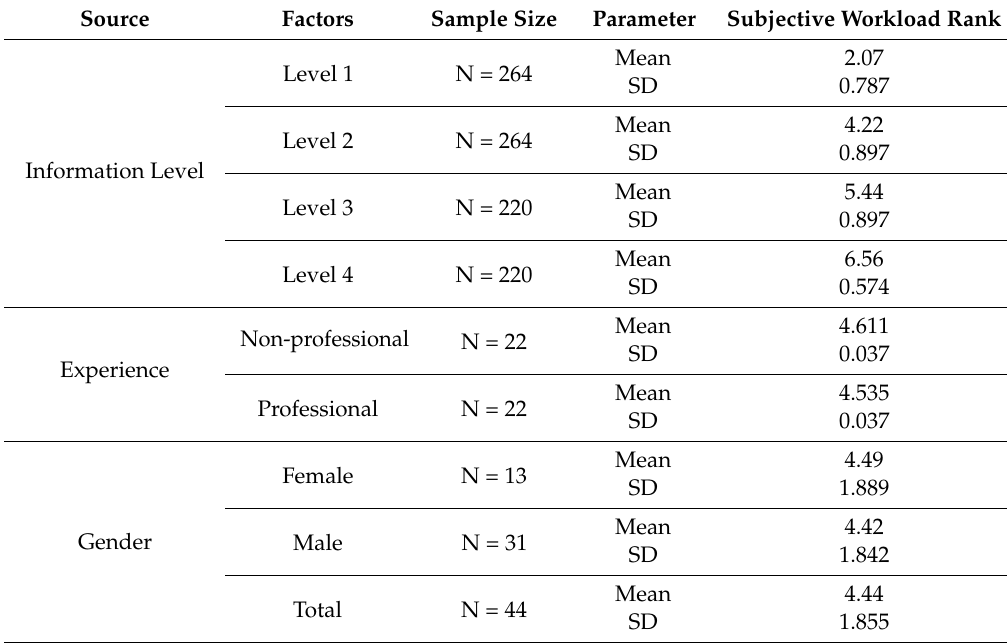
Table 4. Descriptive statistical results for subjective workload rank.